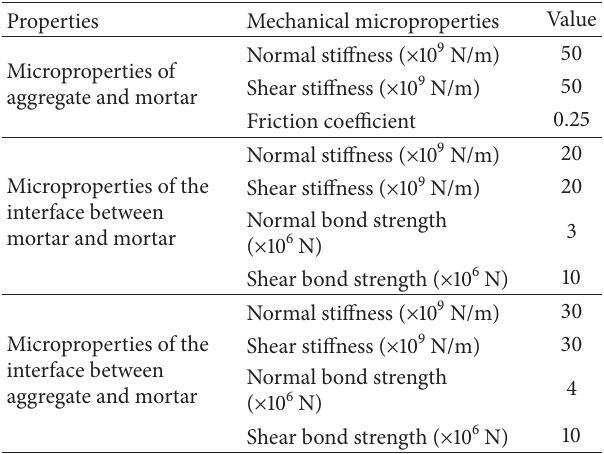
Table 2: Mechanical properties of